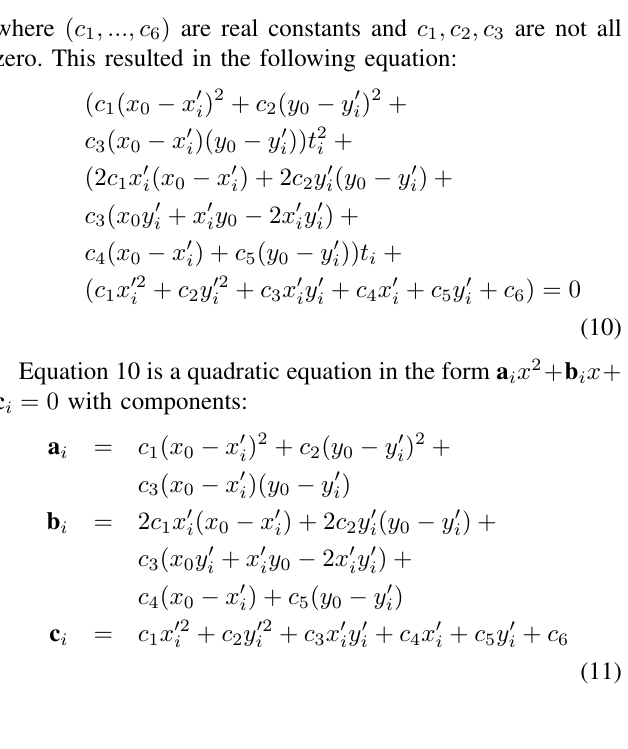
p 0 '' contour edge